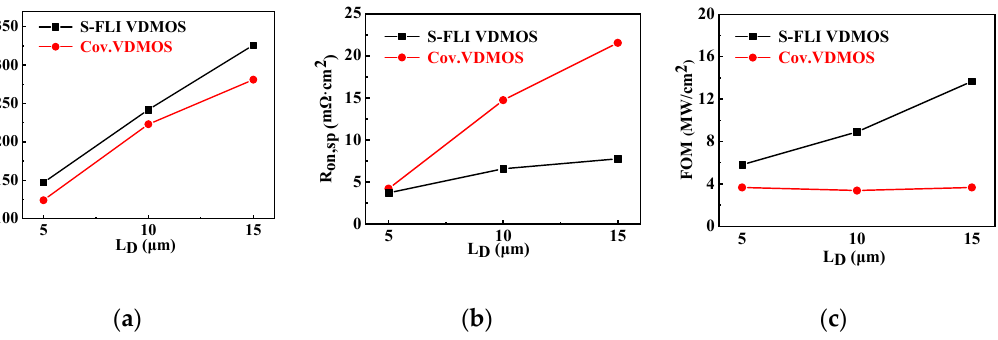
Figure 5. Dependences of ( a ) BV , ( b ) R on,sp and ( c ) figure-of-merit ( FOM ) on L D for the conventional Si VDMOS and S-FLI VDMOS.